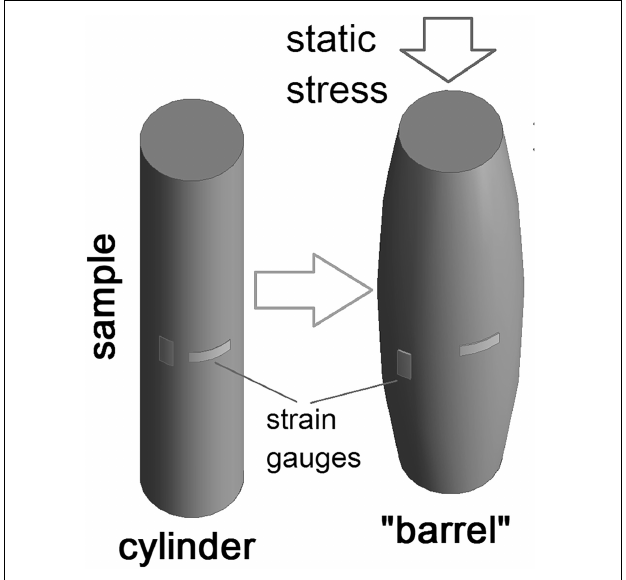
FIGURE 3 | The “barrel” effect under uniaxial static pressure.